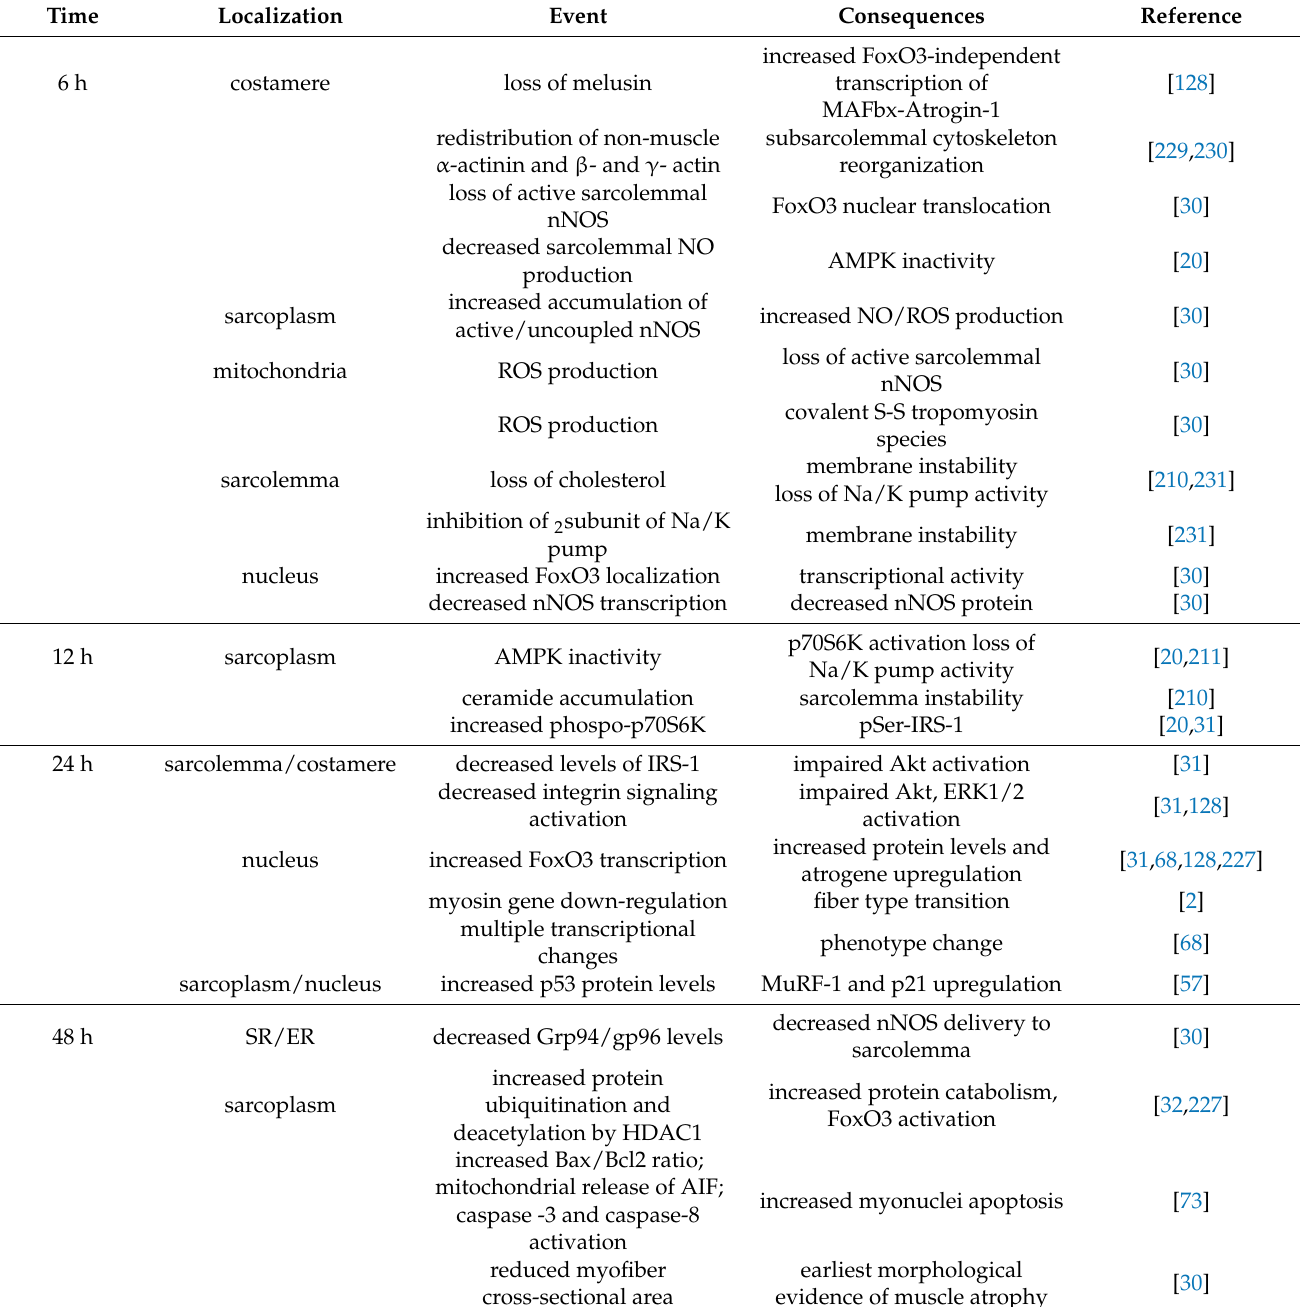
Table 1. Temporal sequence of events induced by unloading/inactivity in rodent hindlimb muscles before the appearance of myofiber